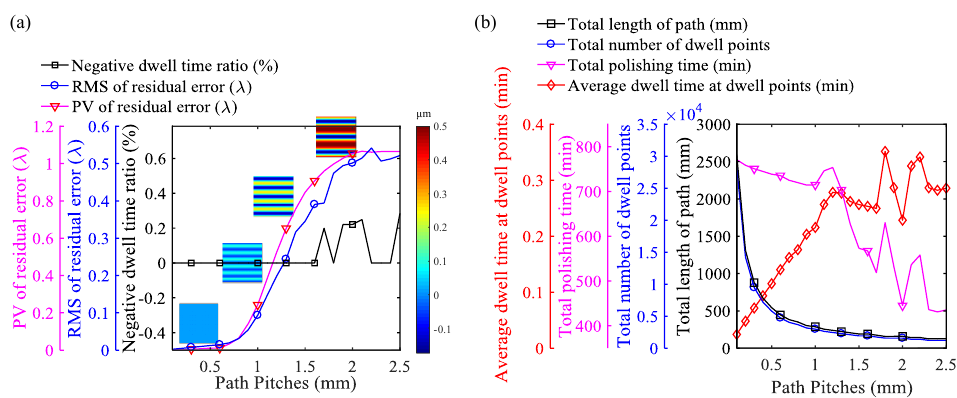
Figure 2. Effect of path pitch on ( a ) residual error and ( b ) other path parameters (bulk material removal depth = 0.5 µ m).